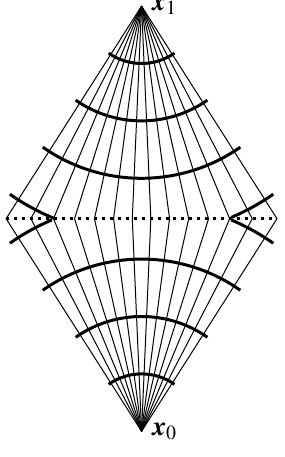
Figure 1: A representation of one possible way that atoms at x 0 and x 1 might exchange a photon. The thin lines comprise a single set of path integral trajectories, corresponding to one particular set c 1 . These trajectories are straight except for at the mid-plane (dotted line), and can be jointly reinterpreted as a single field (such that the trajectories are normal to the phase fronts). The phase fronts of the corresponding field are noted with thick lines. In this case, the phase of the field must be discontinuous at the mid-plane, where the original trajectories change slope.